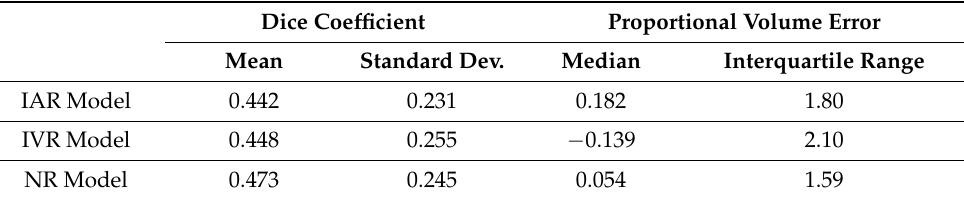
Table 1. Descriptive statistics comparing each model’s standard predictions and the corresponding follow-up lesion segmentations. Recanalization outcomes are abbreviated IAR (intra-arterial therapy, recanalizing), IVR (intravenous tPA, recanalizing), and NR